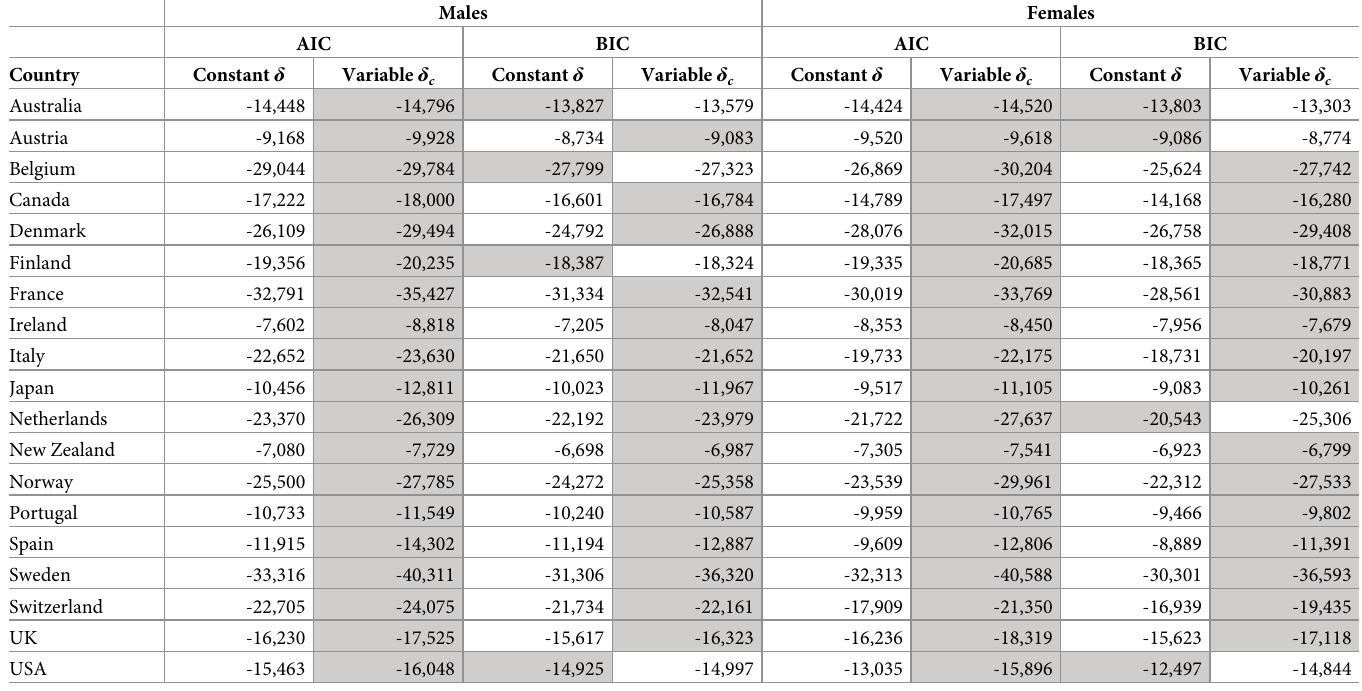
Table 2. Statistical tests for δ c = δ 8 c